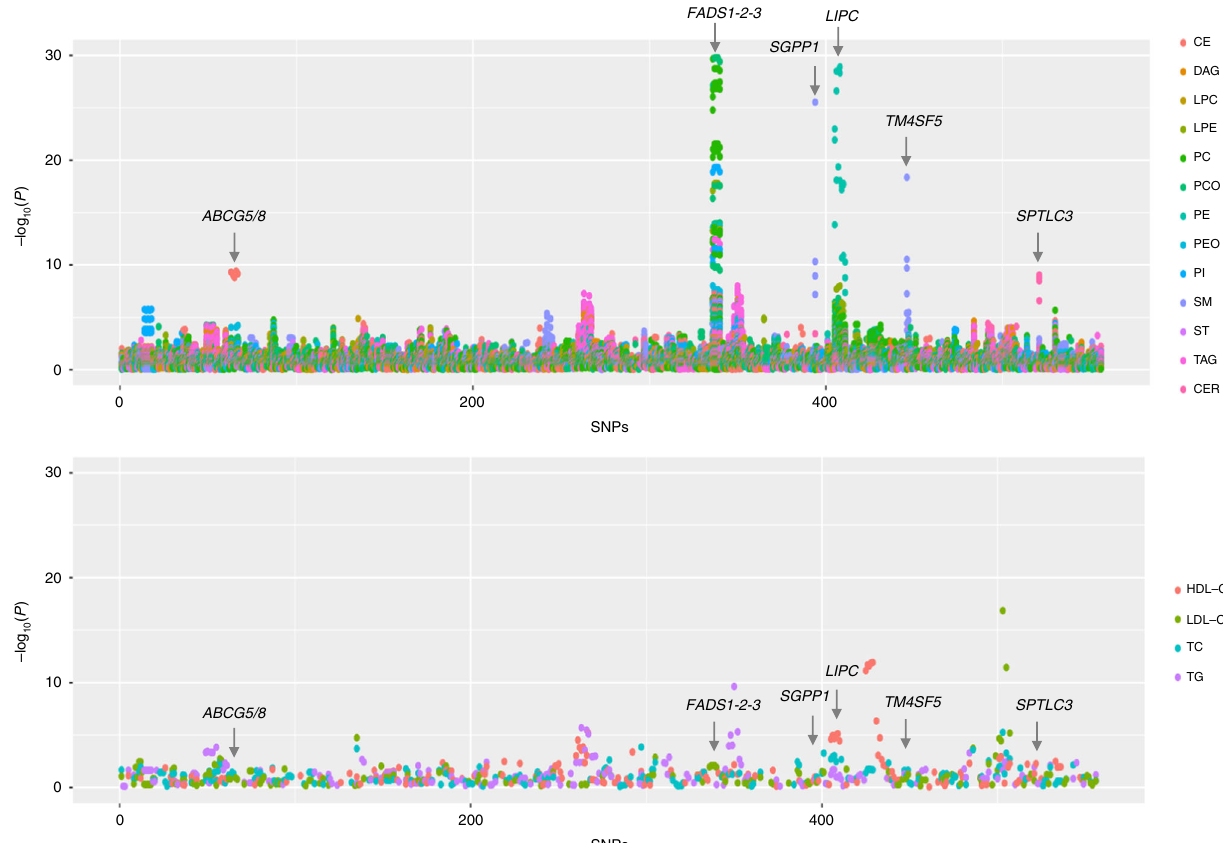
Fig. 7 Association of known variants for traditional lipids with lipid species and traditional lipids. The P- values for the associations of the lead SNPs (557 SNPs available in our data set) identi fi ed through different genome-wide or exome-wide studies of traditional lipids (HDL-C, LDL-C, TG and TC) with lipid species (upper panel) and traditional lipids (lower panel) are plotted. The y -axis in the upper panel is capped at − log10 P- value = 30 for better representation of the data. The SNPs on the x -axis are serially arranged based on their chromosomal positions and as listed in the Supplementary Data 8. The points on the plots are colour coded by the lipid classes in the upper panel and traditional lipid in the lower panel. CER ceramide, DAG diacylglyceride, LPC lysophosphatidylcholine, LPE lysophosphatidylethanolamine, PC phosphatidylcholine, PCO phosphatidylcholine-ether, PE phosphatidylethanolamine, PEO phosphatidylethanolamine-ether, PI phosphatidylinositol, CE cholesteryl ester, SM sphingomyelin, ST sterol, TAG triacyglycerol, TC total cholesterol, TG